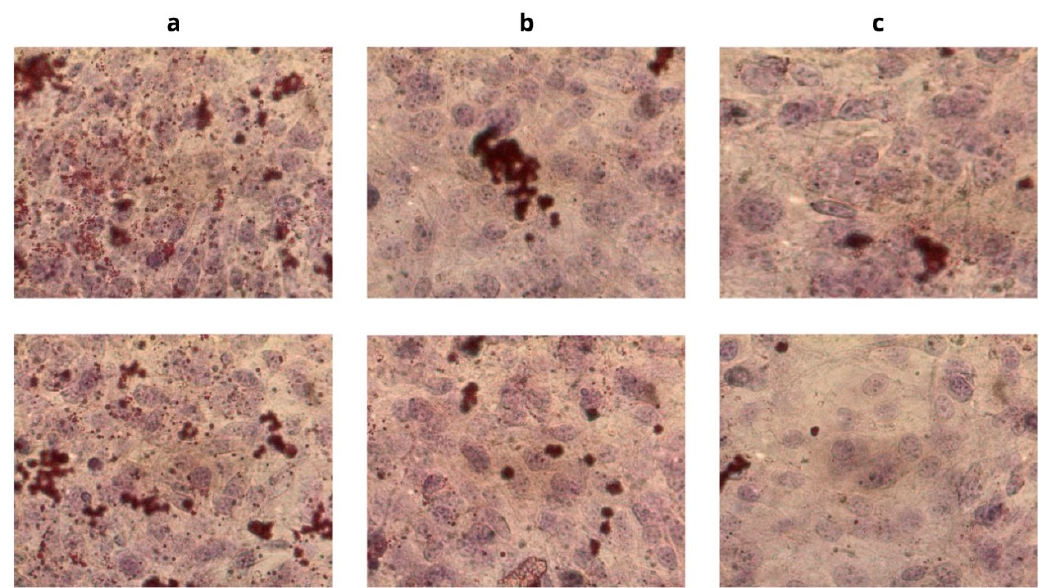
Figure 2. Oil Red O staining assay (40×). Images refers to the stained differentiated adipocytes after incubation with control ( a ) (no nutraceutical ingredient) and two different concentrations of the tested SelectSIEVE ® Rainbow, 0.1% ( b ) and 0.2% ( c ).